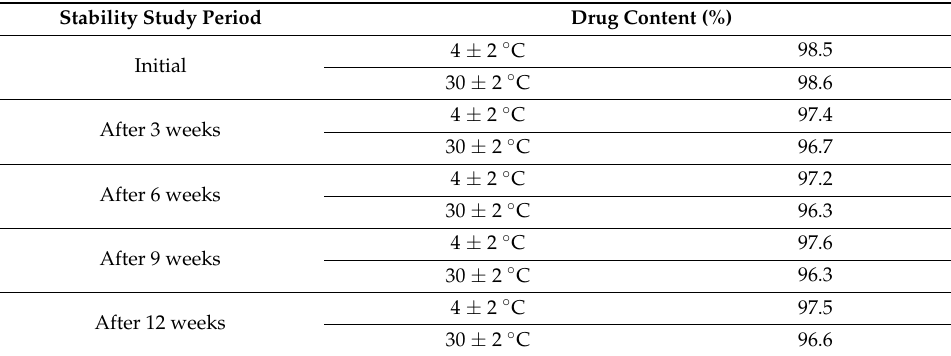
Table 4. Stability studies of P. granatum ethosome